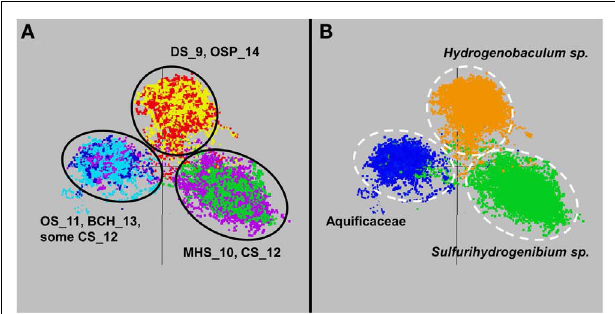
FIGURE 3 | Nucleotide word frequency PCA plots of metagenome assemblies from sixAquificales streamer communities inYNP . (A) Data colored by site (black circles): DS_9 = yellow and OSP_14 = red; MHS_10 = green and CS_12 = violet; OS_11 = dark-blue and BCH_13 = light-blue. (B) Identical PCA orientation with phylogenetic analysis to the closest reference genomes (white-dashed circles): orange = Hydrogenobaculum, green = Sulfurihydrogenibium, dark-blue = Aquificaceae (no reference genomes adequately describe